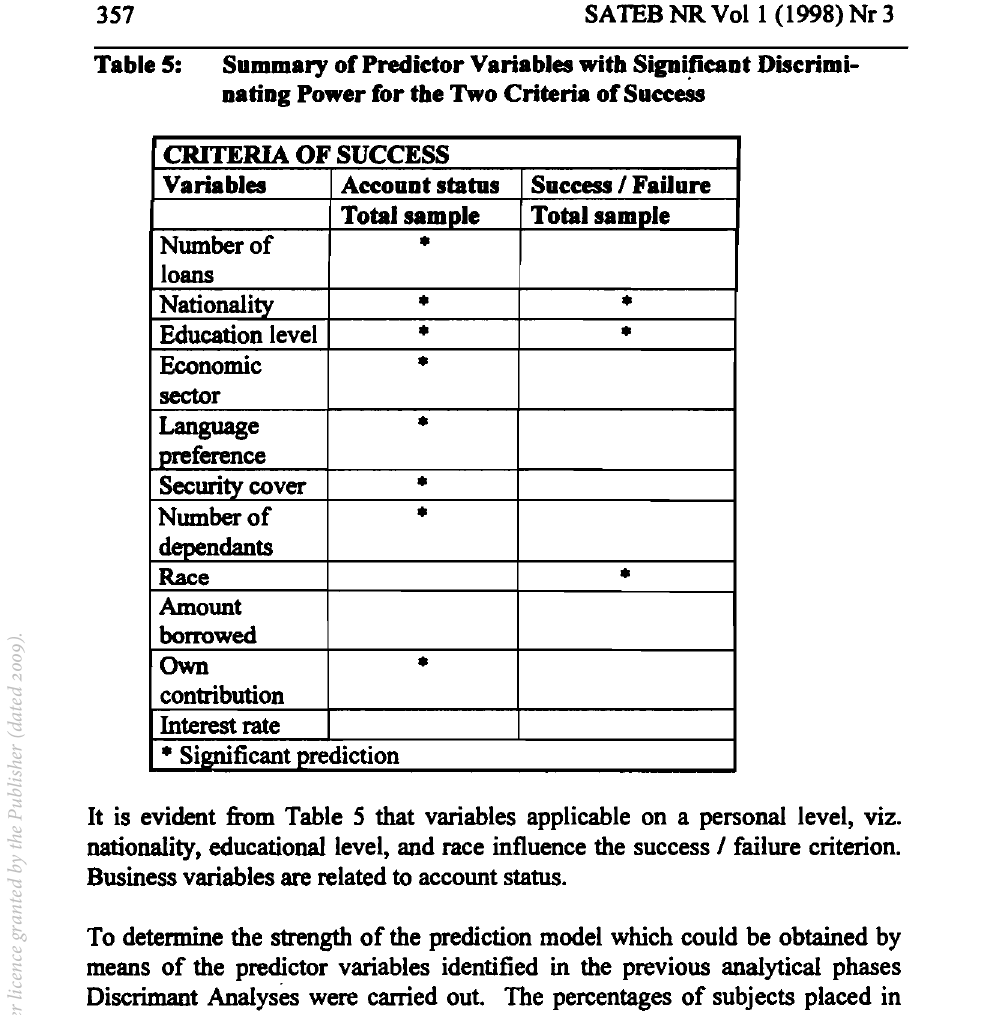
Summary of Predictor Variables with Signi~eant Discrimi nating Power for the Two Criteria of